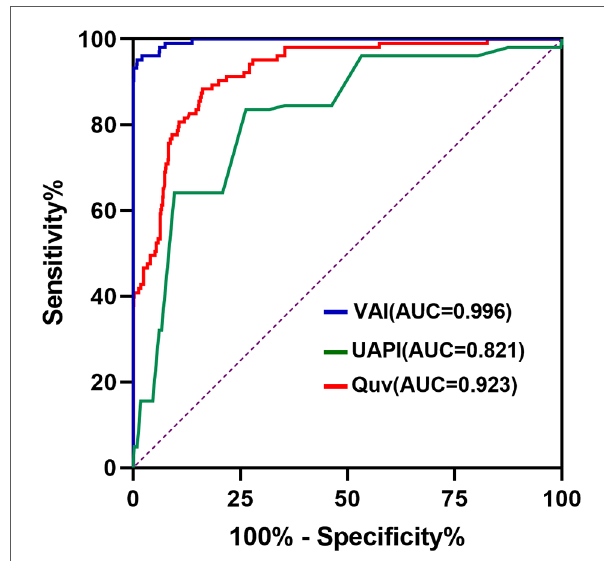
FIGURE 4 Receiver-operating characteristics curve of venous – arterial index (VAI), umbilical vein blood fl ow volume (Quv) and umbilical artery pulsatility index (UAPI) in the control and compromised groups. The cutoff value of VAI is 120 ml/min/kg.